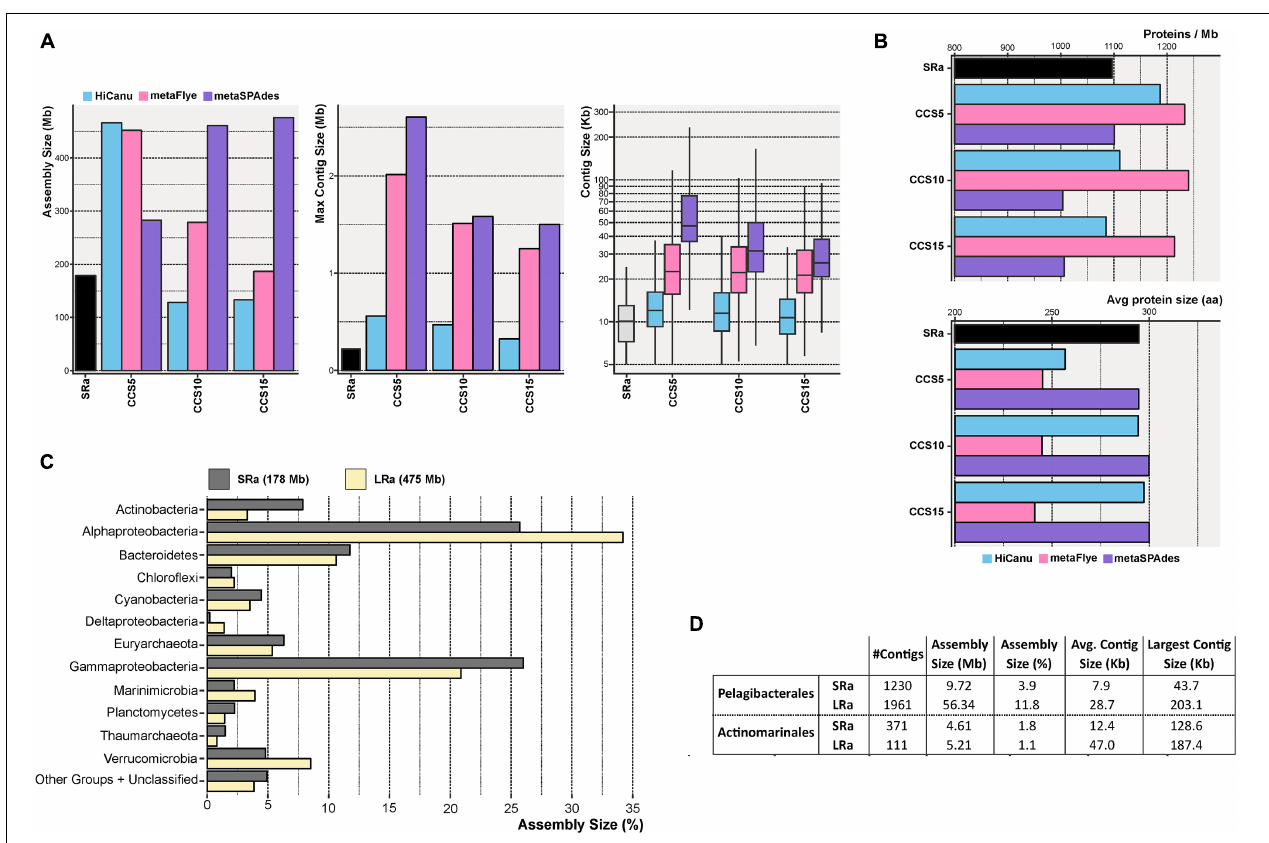
FIGURE 2 | (A) Bar and box plots indicating the total assembly size, maximum contig length, and contig size distribution for the Illumina (SR) and PacBio CCS5, CCS10, and CCS15 assemblies. CCS reads were assembled with HiCanu, metaFlye, and metaSPAdes (blue, pink, and violet bars, respectively). (B) Similar to panel (A) , but representing the number of predicted proteins assembled per megabase (upper panel) and the average protein size (lower panel). (C) Taxonomic classification at the level of the phylum of the resulting Illumina (SRa) and PacBio CCS15 (LRa) assemblies. The phylum Proteobacteria was divided into its class-level classification. (D) Summary of the assembly statistics for contigs classified as Ca. Pelagibacterales and Ca. Actinomarinales.